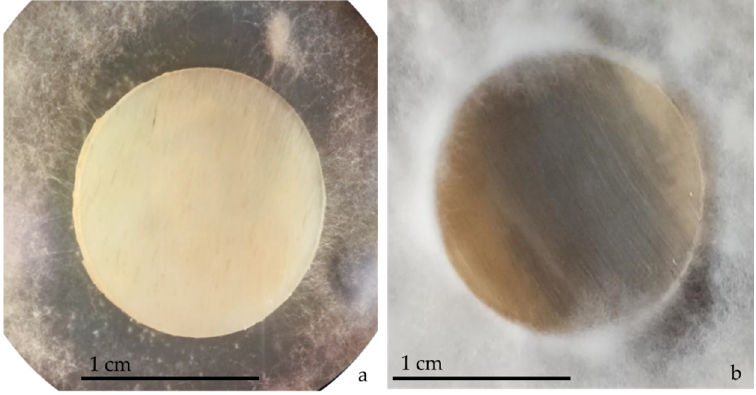
Figure 5. T. mentagrophytes 10340 first visible contact with bovine membrane in WA medium at day 6 ( a ), and T. interdigitale 10379 grown in ½ SDA initial colonization ( b ).